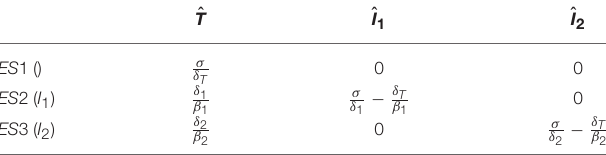
TABLE 1 | The equilibrium states ( ES ) of the basic